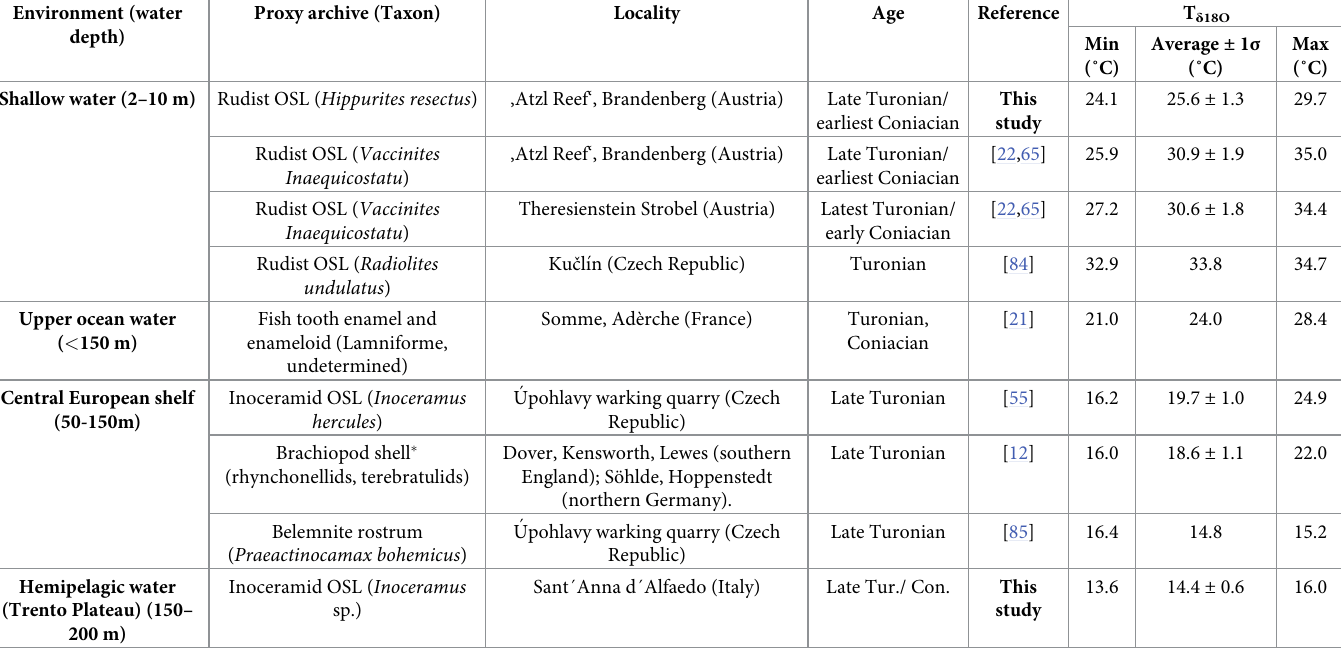
Table 2. Temperature estimates used for the reconstruction of the vertical water temperature gradient at the northwestern margin of the Tethys. Environment (water depth)